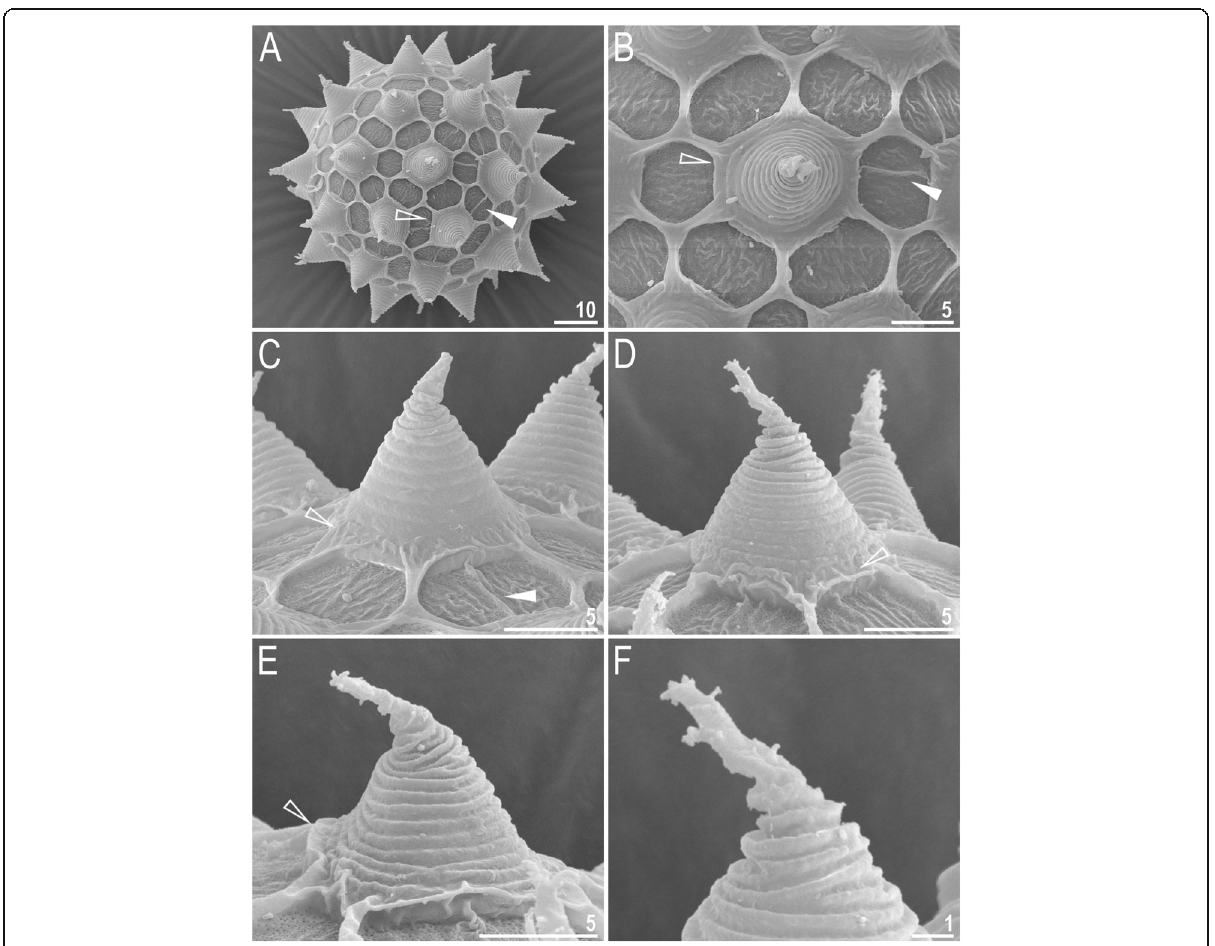
Fig. 37 Macrobiotus margoae sp. nov. from the USA (US.057) – eggs seen with SEM: a – entire view of the egg; b – f – details of the egg surface between processes, areolation and egg processes. Filled flat arrowheads indicate thickenings perpendicular to the process base that divide the areola in the middle, empty flat arrowheads indicate irregular collar around process bases. Scale bars in μ